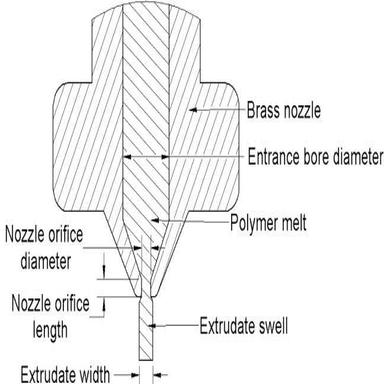
An E3D V6 material extrusion nozzle and the die-swell phenomenon. Significant dimensions of the nozzle are called out and will be referenced in the analysis.